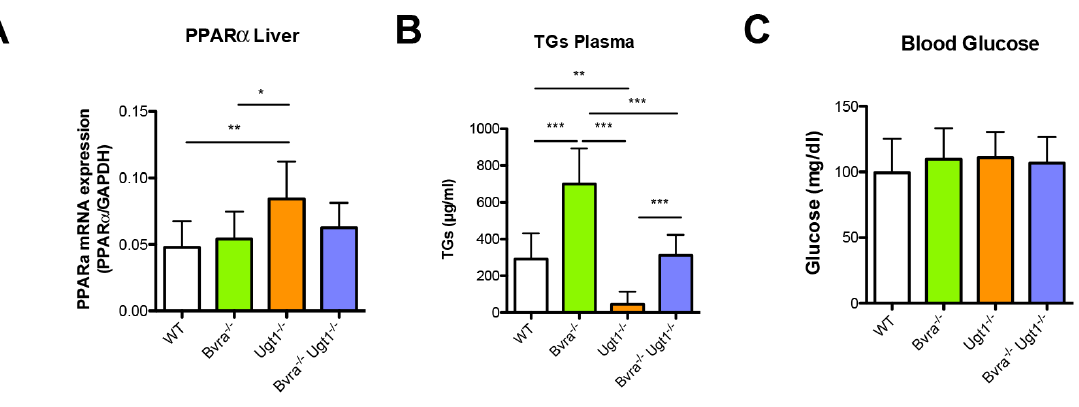
Figure 7. Differences in lipid metabolism in Bvra − / − or Ugt1 − / − mice are absent in the Bvra − / − Ugt1 − / − double knockout mice. ( A ) Hepatic PPAR α mRNA levels in 9-months-old mice. Data represent the mean ± SD (both genders are plotted together). One-way ANOVA, p = 0.005, F = 5.071; Bonferroni tests: *, p ≤ 0.05; **, p ≤ 0.01; WT vs. Bvra − / − Ugt1 − / − , ns; ( B ) triglycerides levels ( µ g/mL) in serum of 9-months-old animals. One-way ANOVA, p ≤ 0.0001, F = 39.19; Bonferroni tests: **, p ≤ 0.01; ***, p ≤ 0.001; WT vs. Bvra − / − Ugt1 − / − , ns; ( C ) glucose levels (mg/dl) in fasted 9-months-old animals. One-way ANOVA, p = 0.7094, F = 0.4642, ns.